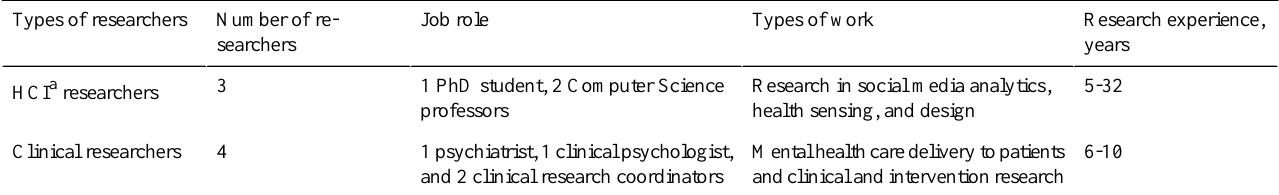
Table 1. Details of the backgrounds of the team